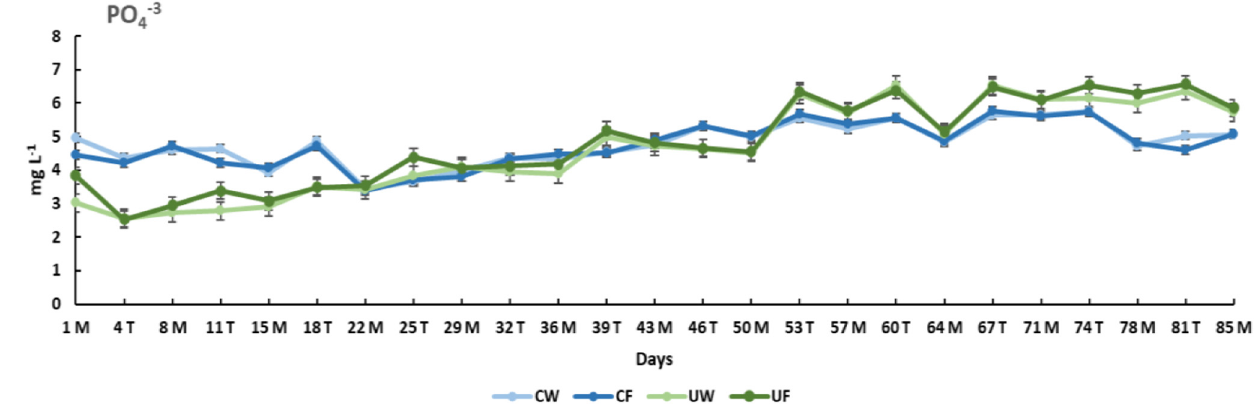
Fig. 2. Mean values (±SE) of orthophospates (PO 3 (cid:1) ) measured every Monday (M) and Thursday (T) CW: water tanks in control-RAS, CF: fi sh 4 tanks in control-RAS, CW: Ulva tanks in Ulva- RAS and UF: fi sh tanks in Ulva- RAS.